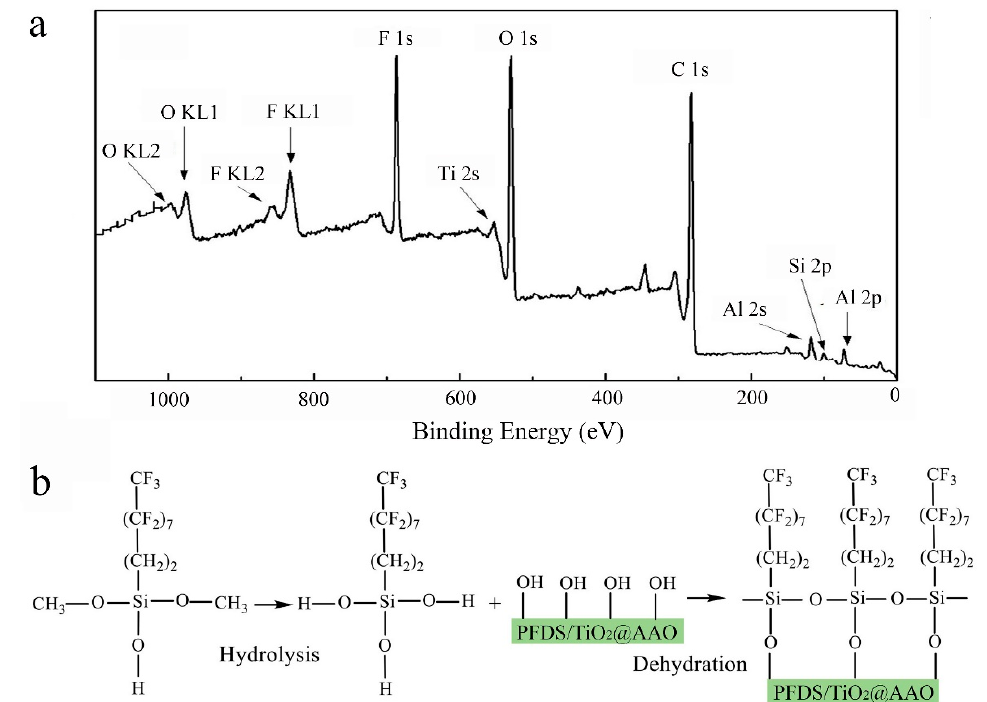
Figure 6. FTIR of the PFDS/TiO 2 @AAO, showing the enlarged view of the spectra in the range 500 cm − 1 to 4000 cm − 1 .